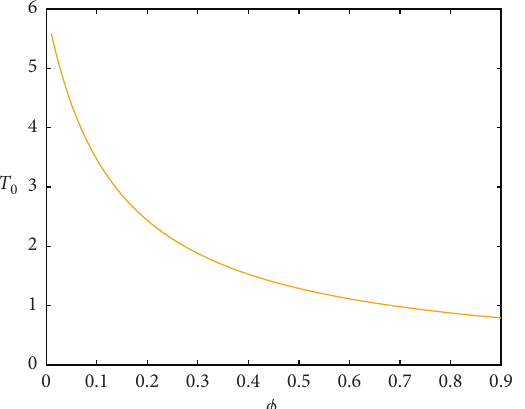
Figure 8: T 0 versus ϕ in the case where β μ � 1, and C W � 1.